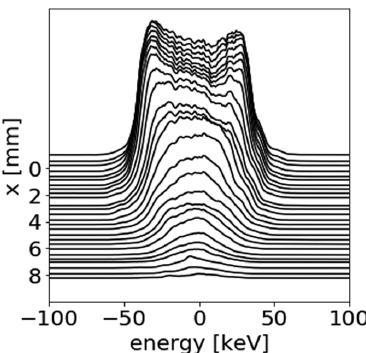
FIG. 2. Measured dependence of energy distribution of a 4D transverse slice: x; x 0 ; y; y on transverse position. The slice is centered over the core in x 0 ; y and y 0 , but varied along x . The beam current during the measurement is 25